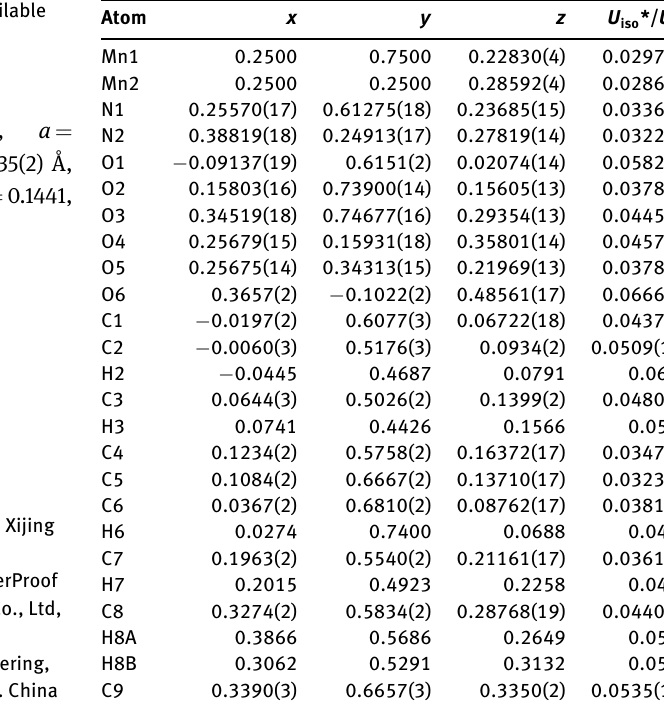
Table 2: Fractional atomic coordinates and isotropic or equivalent isotropic displacement parameters (Å 2